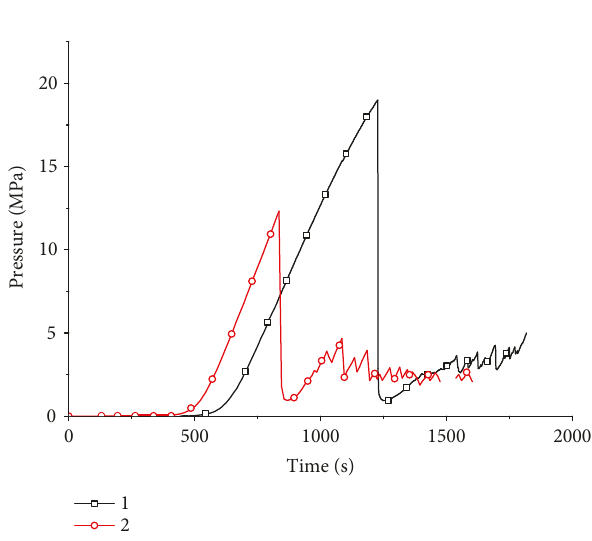
Figure 20: Pressure curves in the core fracturing